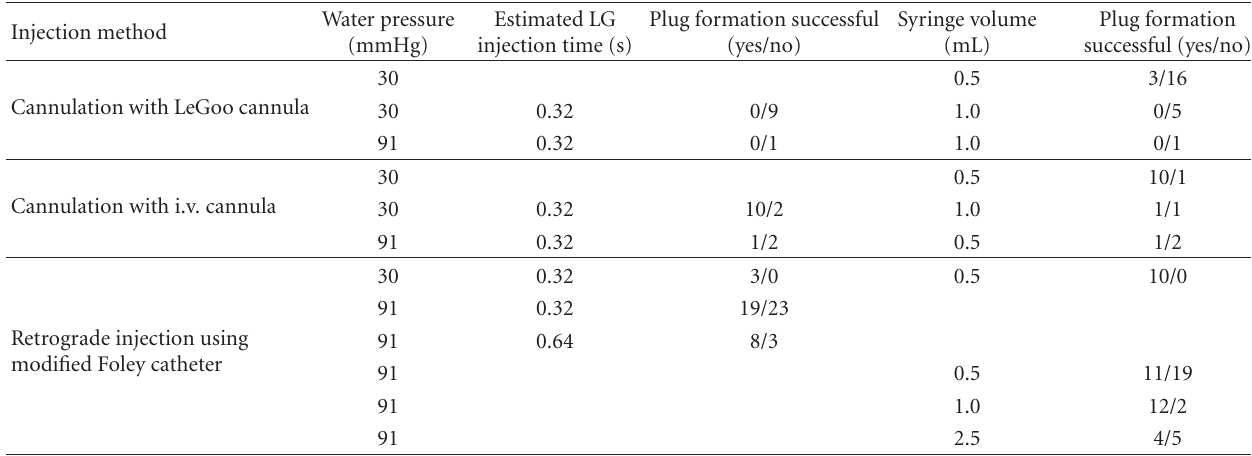
Table 2: E ff ect of injection method, water pressure, estimated LG injection time, and syringe volume on the number of experiments with successful/unsuccessful LG plug formation ∗ .